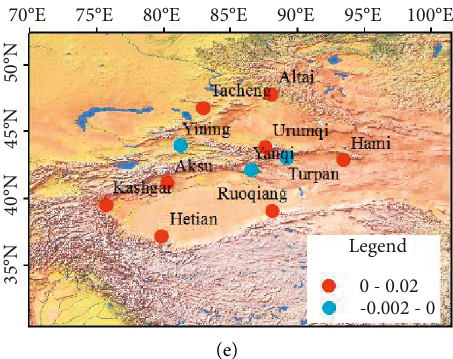
Figure 4: Trend of variability in Xinjiang recorded during 1961–2015. (a) E (decade − 1 ); (d) LCC (% decade − 1 ); and (e) TCC (% decade − 1